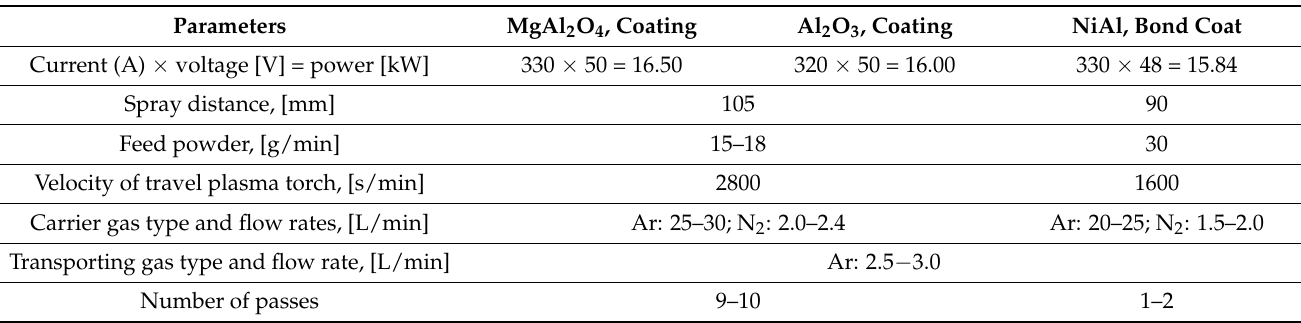
Table 1. Plasma spraying operating